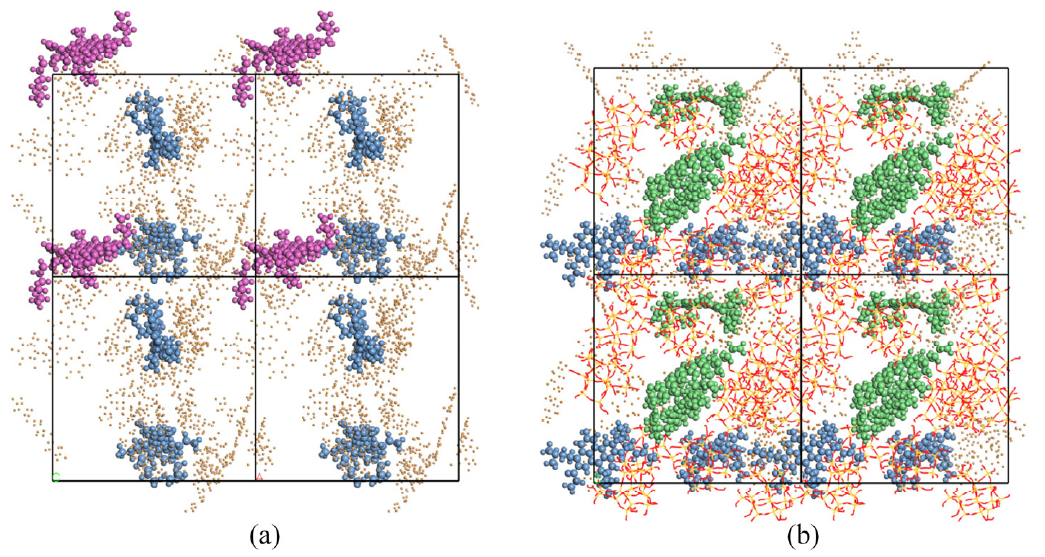
Figure 9. Nanostructure of asphaltene aggregation in blending zone: ( a ) virgin–aged asphalt; ( b ) virgin asphalt–RAM (2 × 2 repetitive units, blue refers to phenol molecules; green refers to thiophene molecules; purple refers to pyrrole molecules; yellow refers to resin molecules).